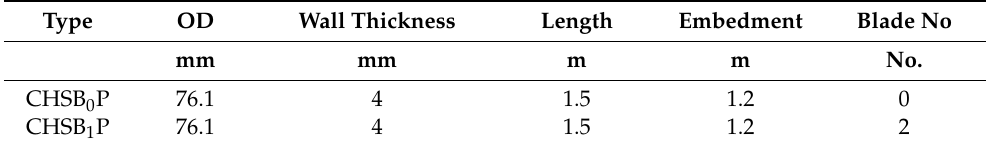
Table 1. Pile geometry parameter.